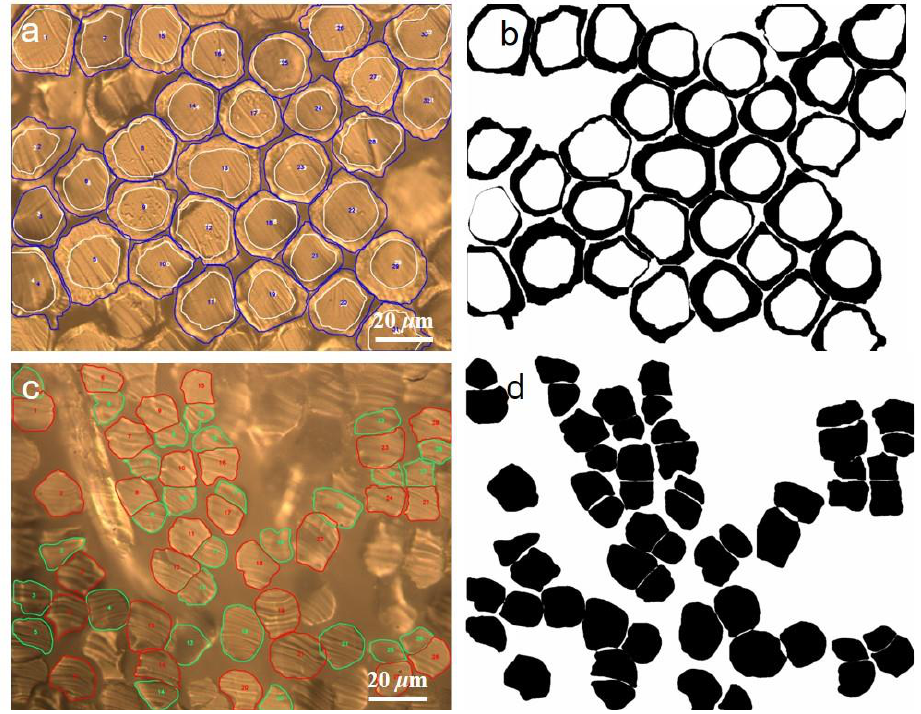
Figure 8. Recognition effect of the image recognition model on each component in bicomponent fiber. ( a , b ) images showed the effect of identification of the sheath and core layers by recognition models,( c , d ) showed the effects of image recognition models on identifying each component of side-by-side bicomponent fibers.